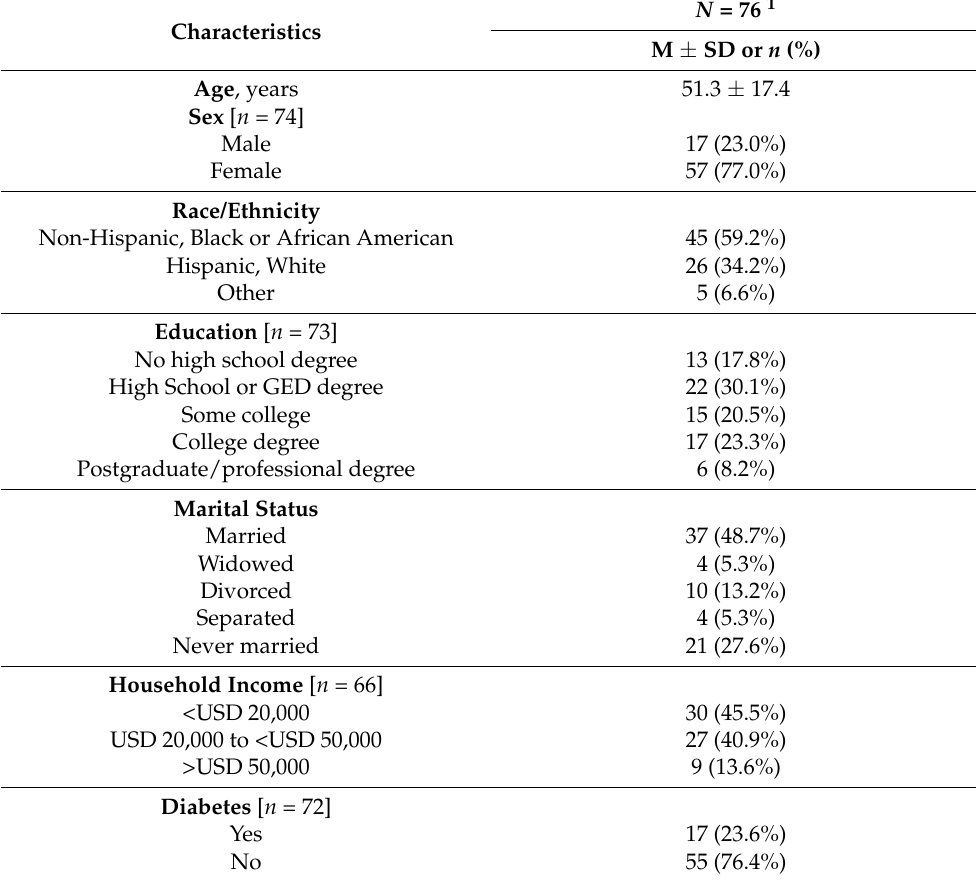
Table 1. Baseline demographics and health condition characteristics of adults participating in the Cooperative Extension team-based challenge with complete